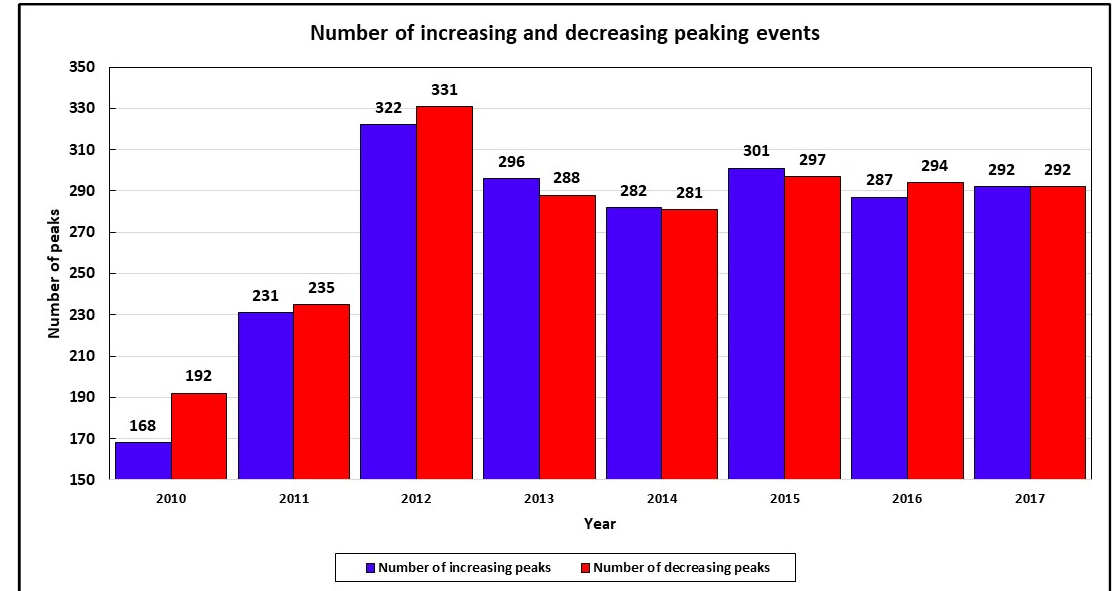
Figure 4. Number of peaking events per year in Hol 1 hydro plant.